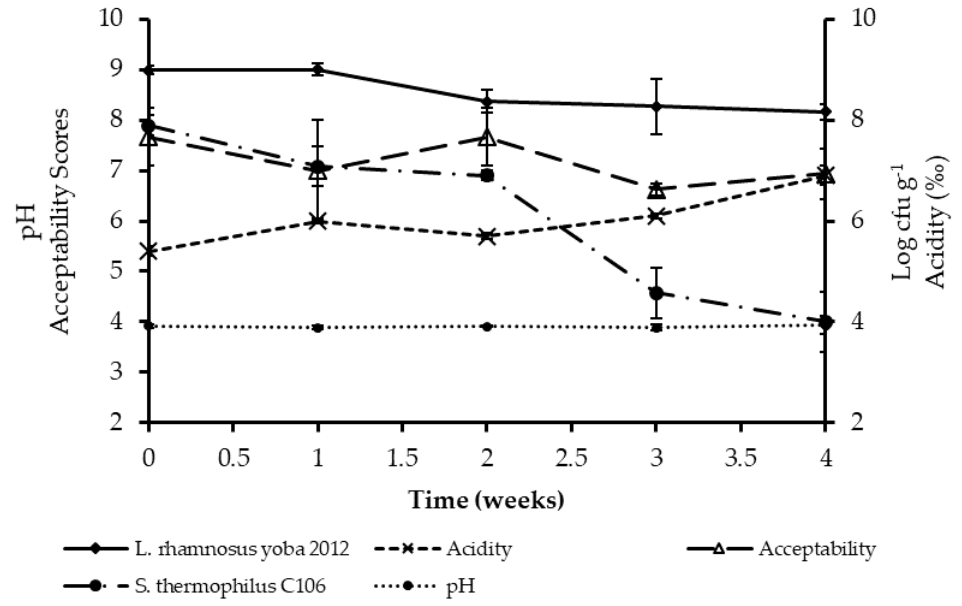
Figure 2. Shelf stability of probiotic kwete containing L. rhamnosus yoba 2012 and S. thermophilus C106 during storage at 4.0 ° C. Data points for pH, acidity, L. rhamnosus yoba 2012, and S. thermophilus C106 counts are means of three independent fermentations, while data points for acceptability are means of eight panelist scores. Error bars represent standard deviations. A 9-point hedonic scale (1 = dislike extremely and 9 = like extremely) was used for acceptability scoring.